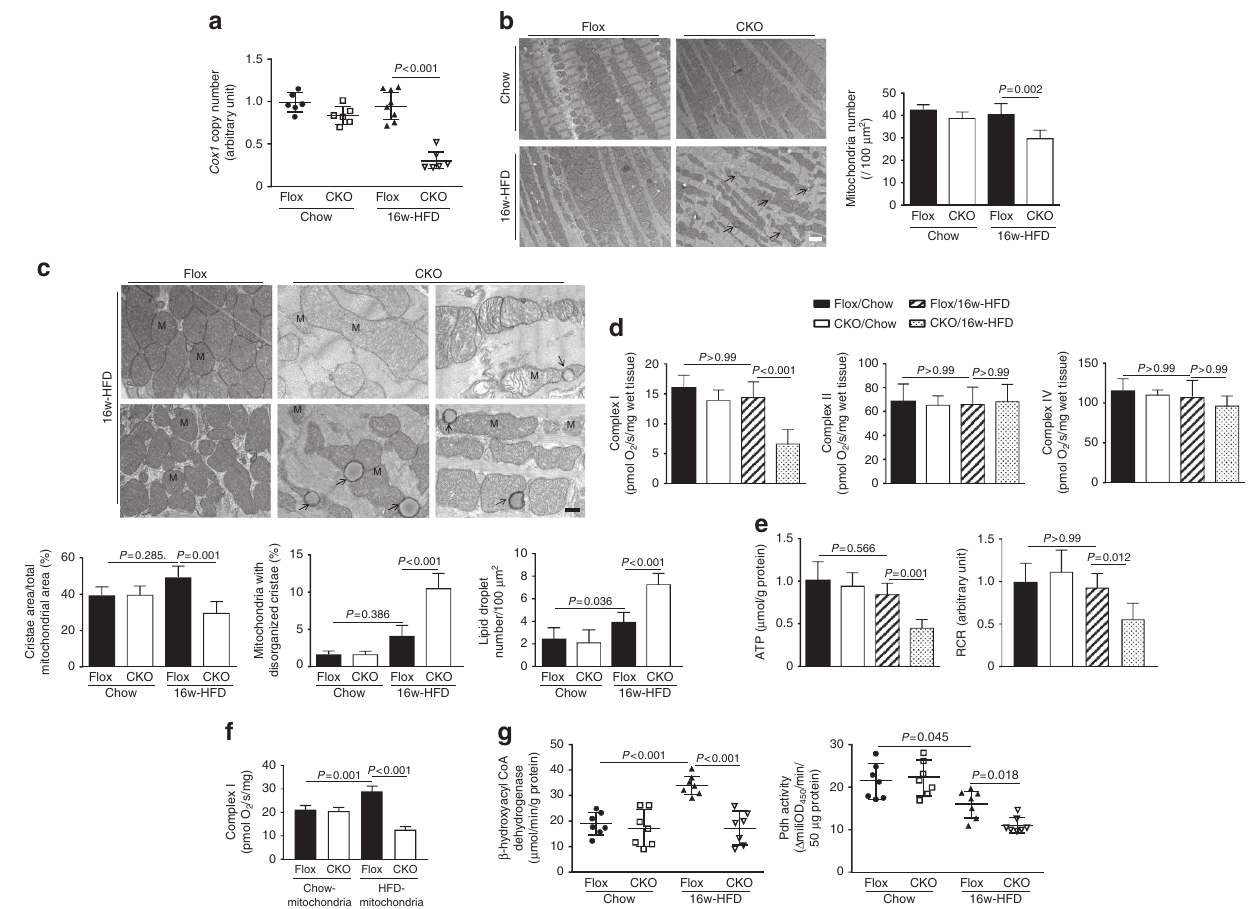
Fig. 3 Mitochondrial morphological and functional aberrations in HFD-CKO hearts. a The content of mtDNA was measured by the ratio of Cox1 to cyclophilin A. b Mitochondria was examined by TEM (×1400). Representative images showing reduced and disorganized mitochondria cluttering in the cytosol of HFD-CKO hearts ( scale bar : 2 µ m). The quantitative analysis of mitochondria number is provided in bar graphs. c Higher magni fi cation (×4800) of TEM images show disarrayed cristae, vacuoles and a reduced electron density of the matrix in the HFD-CKO mitochondria ( scale bar : 0.5 µ m), M symbolize mitochondria, arrows indicate lipid droplets. Quantitative analysis of cristae area, disorganized cristae in mitochondria, lipid droplet number, respectively, is provided in the bar graphs ( n = 6 mice per group). d Respiratory rates of mitochondrial ETC complexes were measured in saponin-permeabilized myocardial fi bers. With glutamate/malate as substrates, complex I respiratory rate was found to be decreased in HFD-CKO hearts. e Signi fi cantly reduced ATP production in HFD-CKO hearts was determined. Consistent with this, the respiratory control ratio (RCR) was lower in HFD-CKO hearts. f Analysis of complex I in mitochondria homogenates using palmitoylcarnitine as a substrate showed that ERK5-de fi cient mitochondria of HFD-fed mice had a reduction in FA-driven respiration. g Mitochondrial fuel oxidation was suppressed in HFD-CKO hearts evidenced by activity measurement of β -hydroxylacyl CoA dehydrogenase and pyruvate dehydrogenase (Pdh) ( n = 7 mice per group). Data are presented as means ±